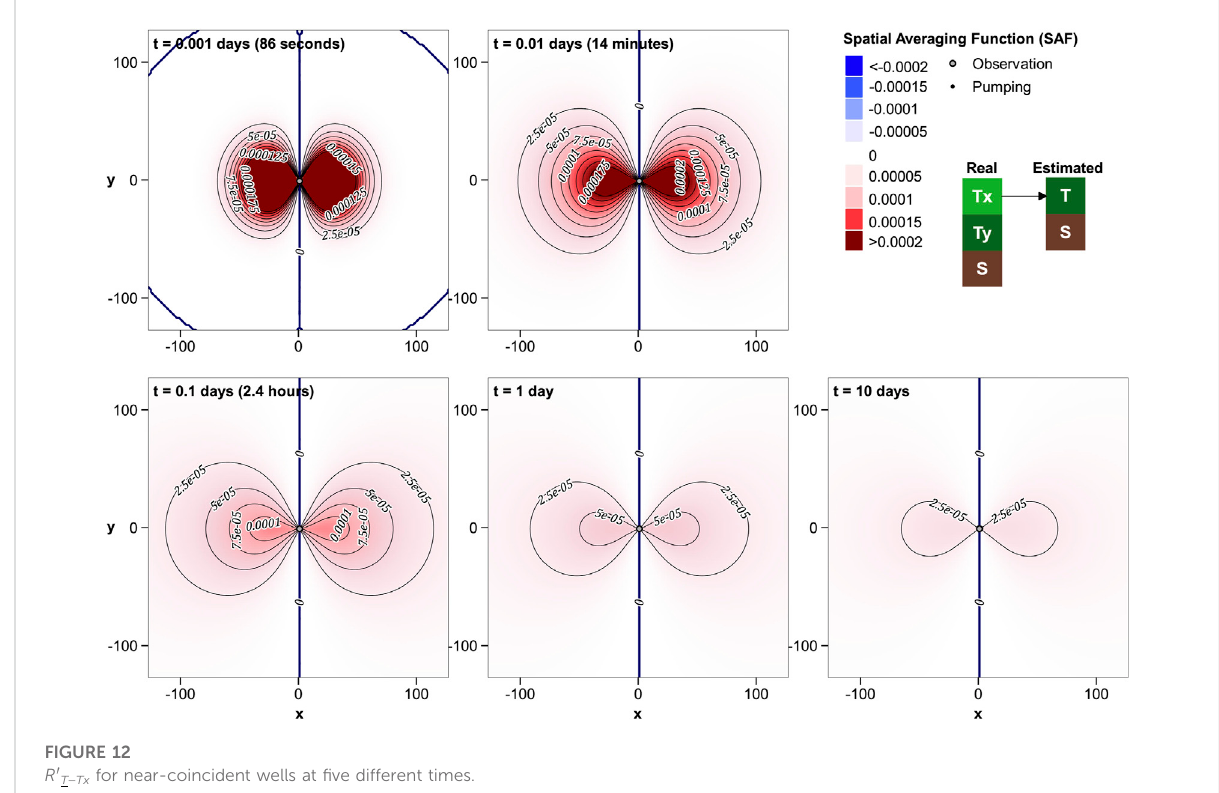
FIGURE 12 R ′ T − Tx for near-coincident wells at fi ve different times.